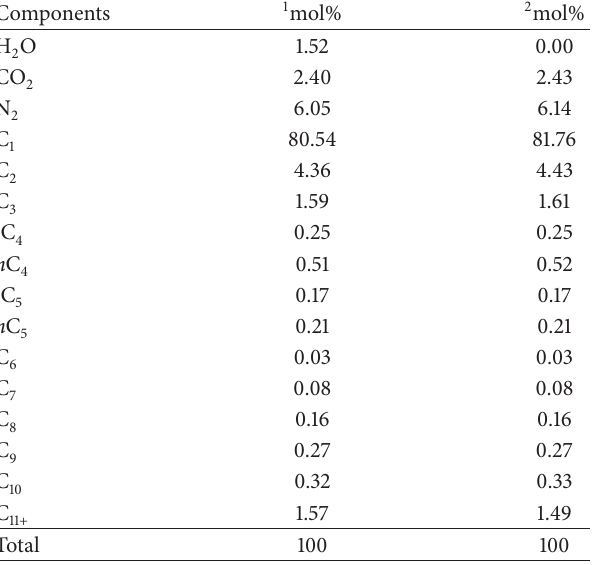
Table 1: Composition of the reservoir fluid